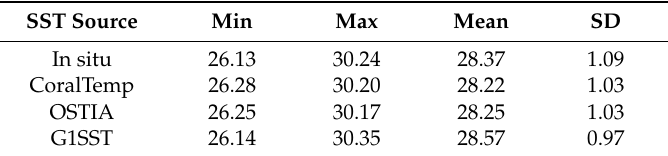
Table 4. Summary of the SST data ( ◦ C) for San Cristobal from 1 March 2019–1 March 2020 (one year) for the averaged in situ loggers, CoralTemp, and OSTIA. The G1SST dataset is only from 1 March